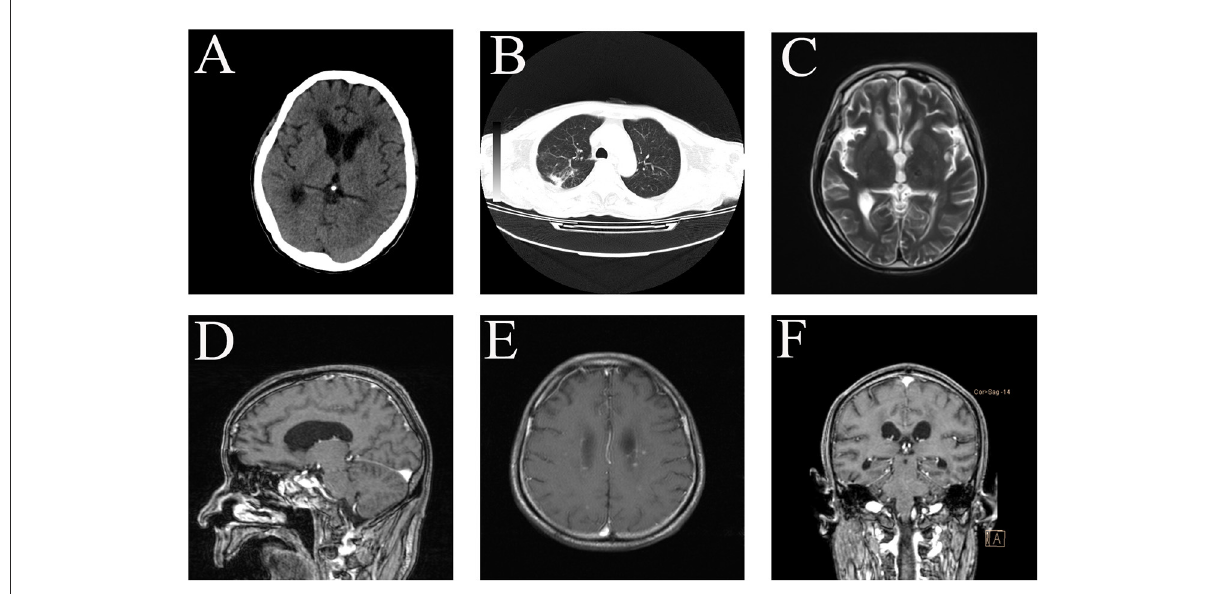
FIGURE2 CT after 2 months of treatment. The size of the lesion and the degree of edema improved significantly (A) . The patient’s upper right pneumonia is better than before (B) . The patient MRI in August 2021 showed that the abscess was significantly absorbed and improved (C–F)